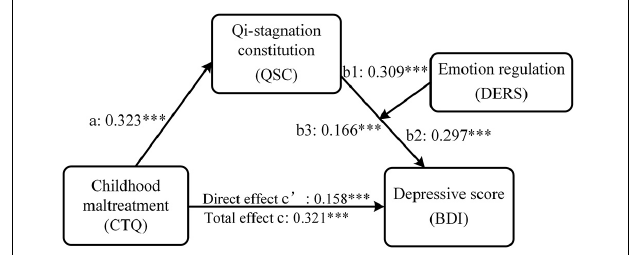
FIGURE 2 | The moderated mediation model of childhood maltreatment, Qi-stagnation constitution, emotion regulation and depression. Path coefficients were shown in unstandardized regression coefficient. CTQ, total score of the Childhood Trauma Questionnaire-Short Form (CTQ-SF); QSC, conversion score of the Qi-Stagnation Constitution Scale; DERS, total score of the Difficulties in Emotion Regulation Scale; BDI, depressive sore using Beck Depression Inventory-II. ∗∗∗ p < 0.001.